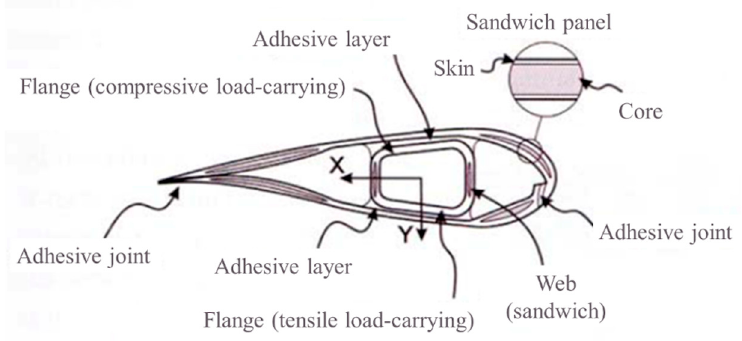
Figure 4. Cross-section of a wind turbine blade [42].